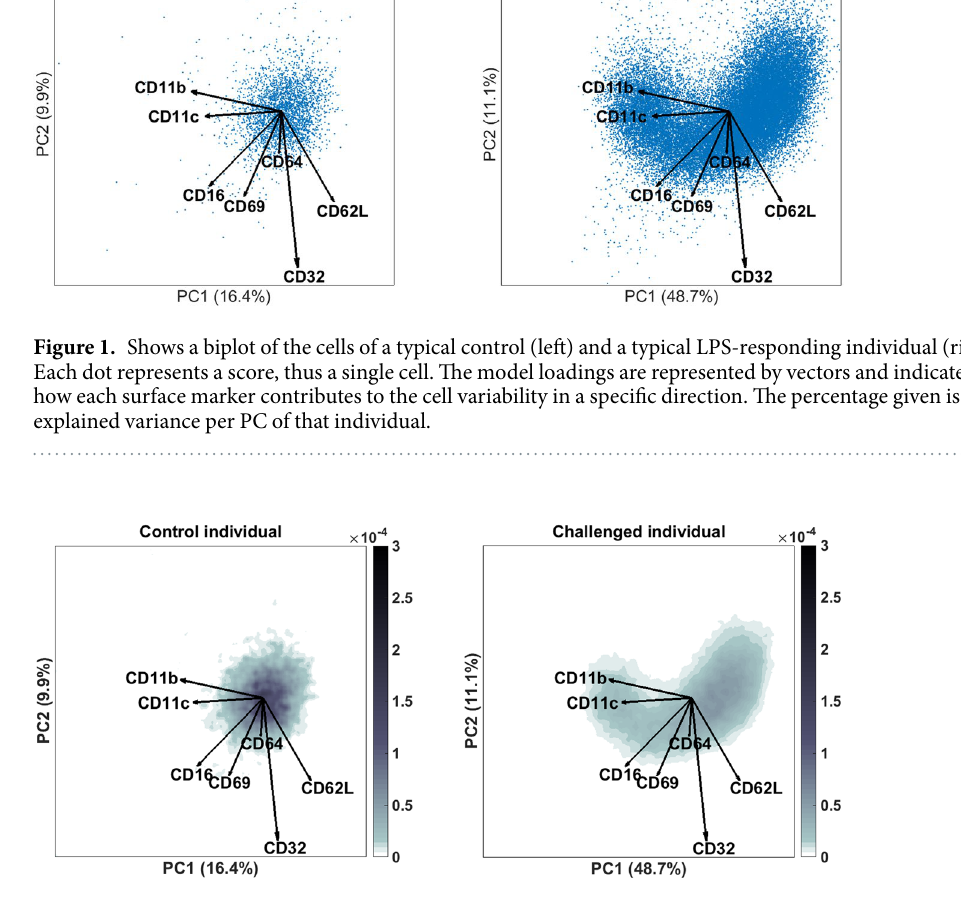
Several existing methods for MFC data analysis may predict accurately the phenotype a sample presents, but fail to quantitatively link the interplay between specific markers to e.g . disease specific cells 4 . Several methods use e.g . median fluorescence intensity or work with sequential two-dimensional gating steps to select specific cells. Two-dimensional multiple gating regions of interest are subjectively defined in bivariate plots, but impor- tant information is lost during every sequential two-dimensional gating step. Therefore, these methods can be viewed as multiple-univariate or multiple-bivariate and miss the comprehensive link between the four levels. Either approach does not employ the expression of more than two markers of a single cell, such that the MFC data is not interpreted to its full potential. Recently, several multivariate methods have been developed that provide a canonical view on the (co)-expression of all markers. Fischer Information Nonparametric Embedding (FINE) 5 uses Multidimensional Scaling to observe variability between samples, which may be used to explore response-related patterns. However, the link FINE draws between marker expression and variability between individuals is non-linear, such that relevant connections can only be drawn from post hoc interpretation of the model results. Likewise, the ViSNE 6 approach visualizes the aggregation of cells for each individual by reducing the dimensions with a non-linear t-Distributed Stochastic Neighbour Embedding (t-SNE), such that the representation of single-cells (level 2) can- not be directly linked to the multivariate co-expression of markers (level 1). Moreover, neither method allows a projection of an individual sample (level 3) into the multidimensional model space to evaluate their similarity to samples in the calibration set on which the model was fitted (level 4). Several other methods that were spe- cifically developed for MFC data analysis, use specific representations of the cellular composition of a sample (level 2) to find biomarkers for a clinical phenotype. Frequency Difference Gating 7 (FDG), another method uses probability binning to get an equal number of cells in each bin, based on those measured in the control samples and then identifies bins differentially expressed in a specific (clinical) phenotype. The SPADE method constructs